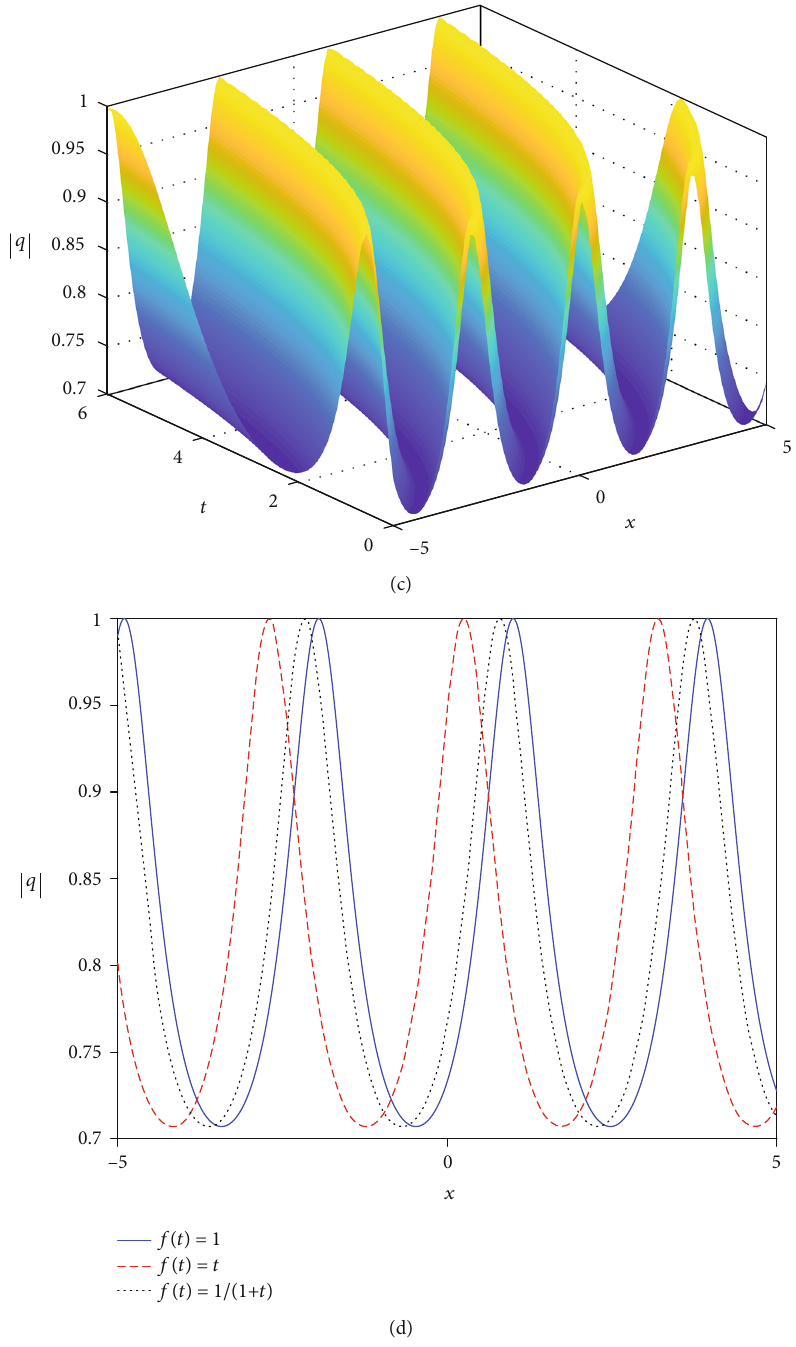
Figure 2: (a – c) The 3D wave shapes of j q j : (a) f ð t Þ = 1 , (b) f ð t Þ = t , and (c) f ð t Þ = 1/ ð 1 + t Þ . (d) The wave propagates along the x